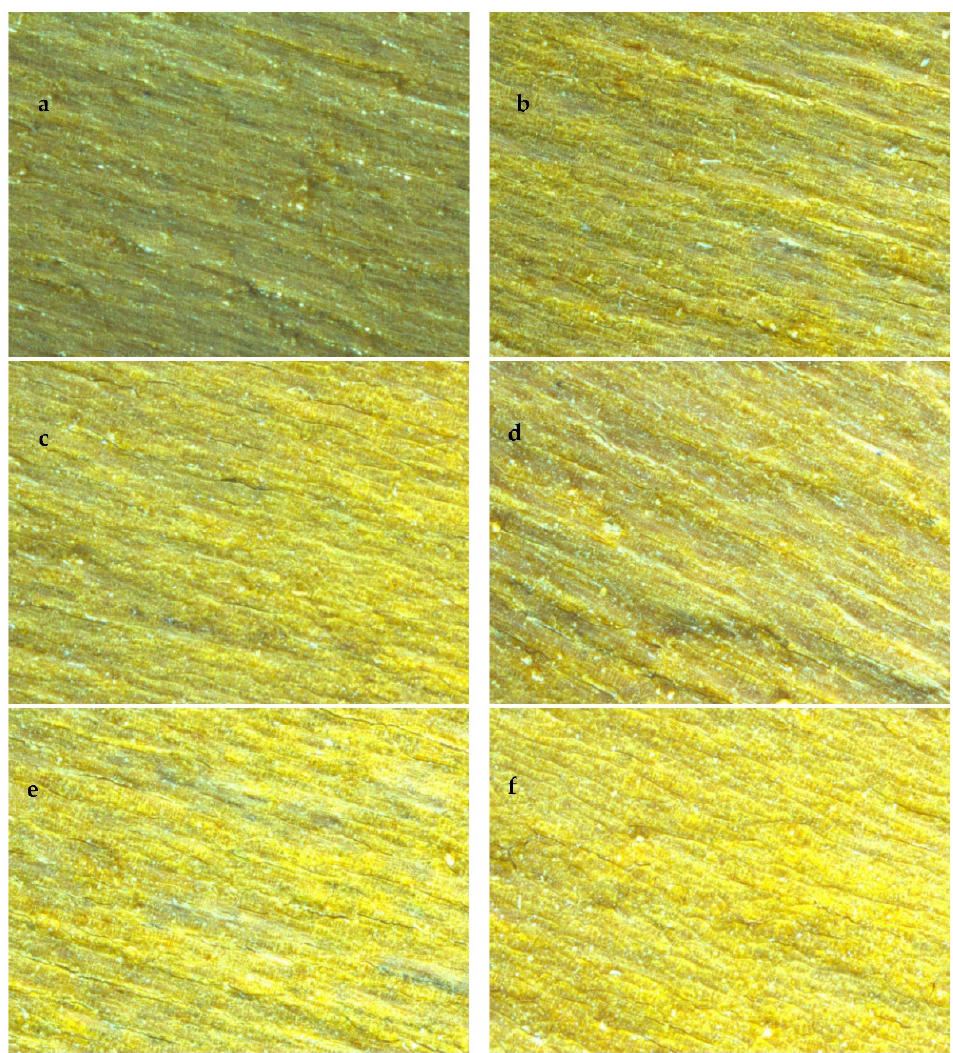
Figure 3. The stereoscopic microscope image of Si–Ti composite film prepared at different Bi 2 O 3 - doped amounts. (( a – f ) are the stereoscopic microscope image of BST0, BST1, BST2, BST3, BST4, BST5).